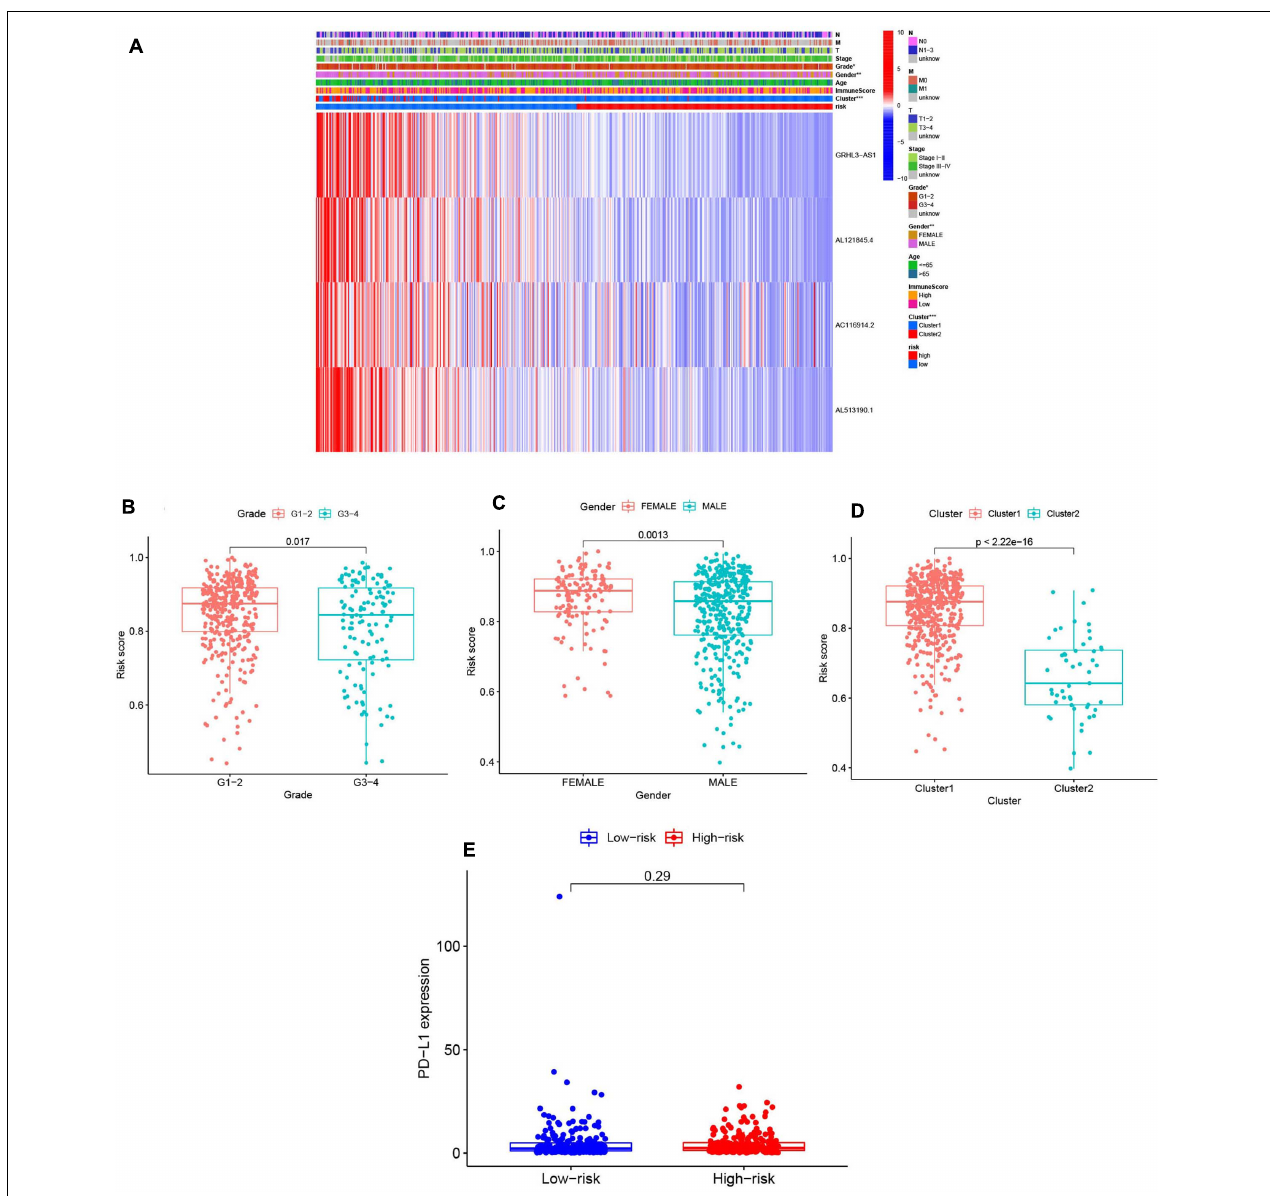
FIGURE 9 | Prognostic risk scores correlated with clinicopathological features and immunoscore in TCGA training cohort. (A) Heatmap and clinicopathologic features of high- and low-risk groups. P < 0.05 ("*"), P < 0.01 ("**"), and P < 0.001 ("***"). (B–D) Distribution of risk scores stratified by grade (B) , gender (C) , and clusterl/2 (D) . (E) The PD-Ll expression level by risk score group in TCGA training